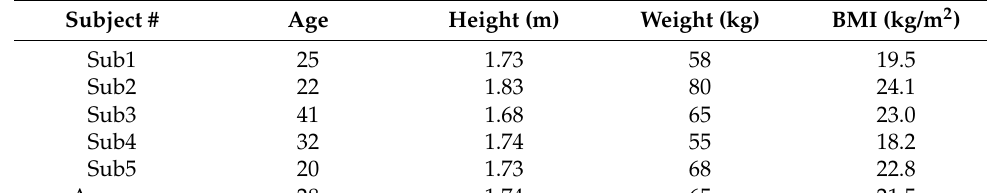
Table 2. The participants’ demographics (Phase 3).